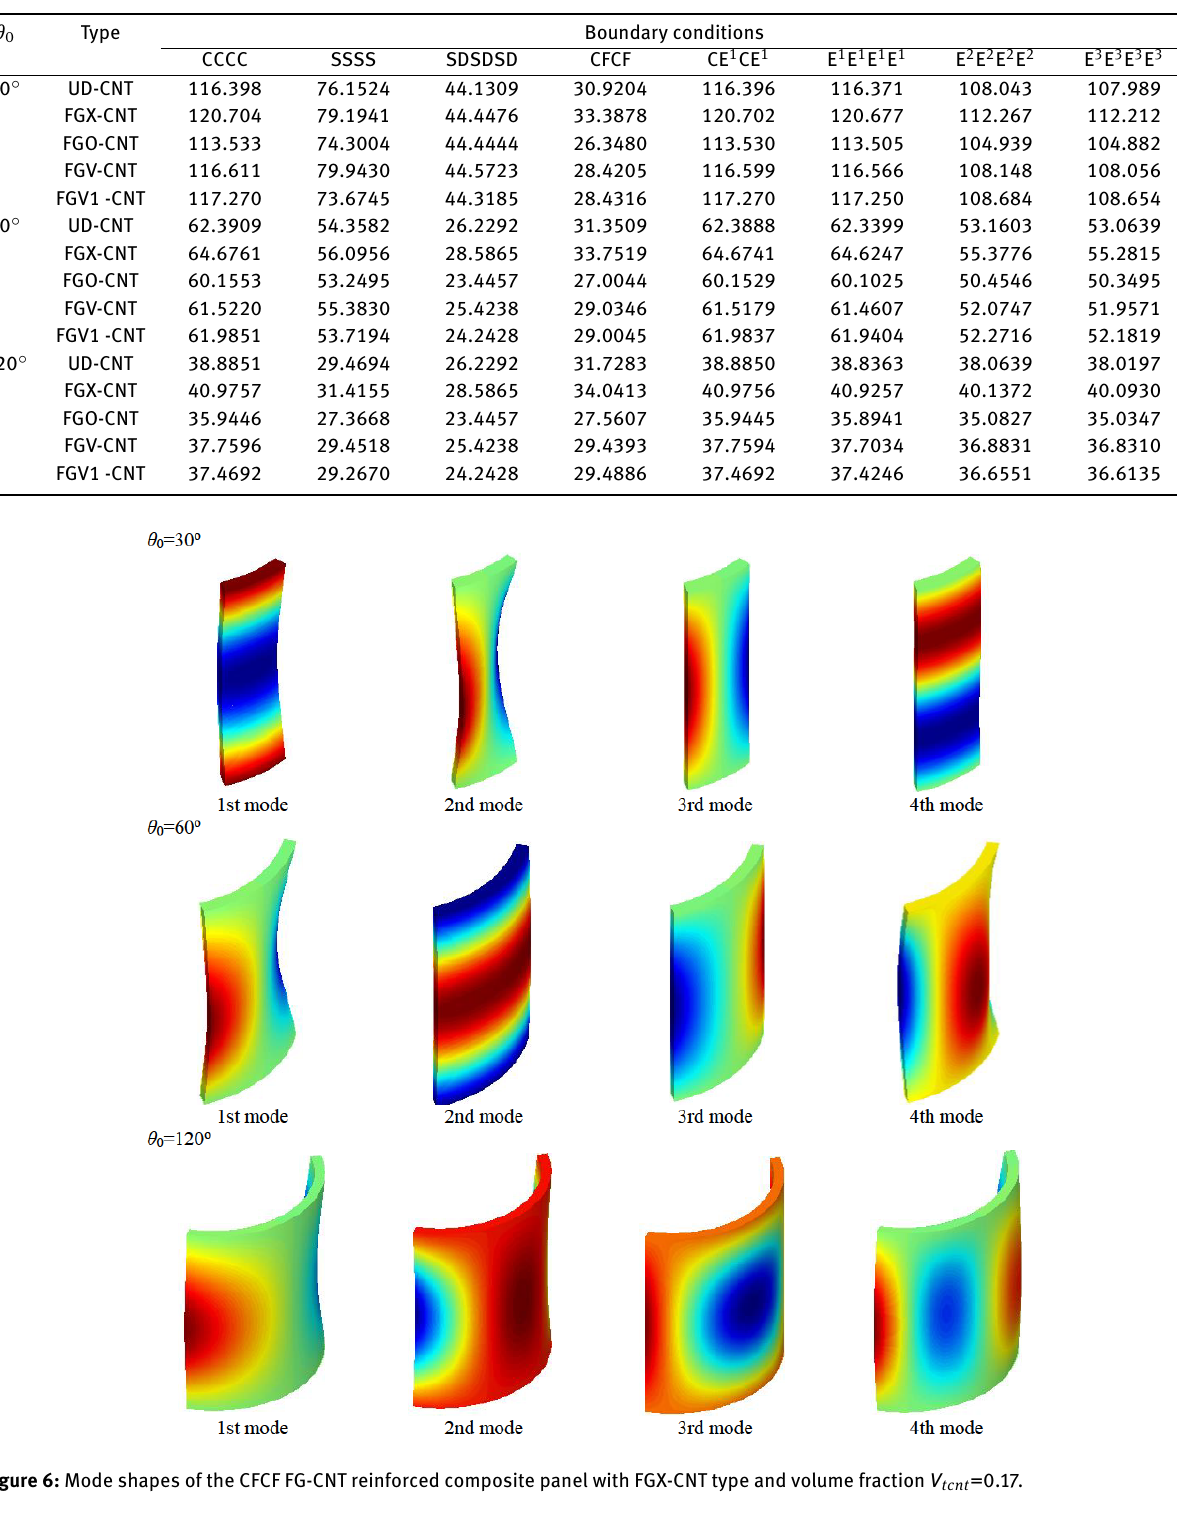
Table 7: Fundamental frequency parameters Ω for FG-CNT reinforced composite panels with various boundary conditions and CNT volume fractions V tcnt = 0.17 .